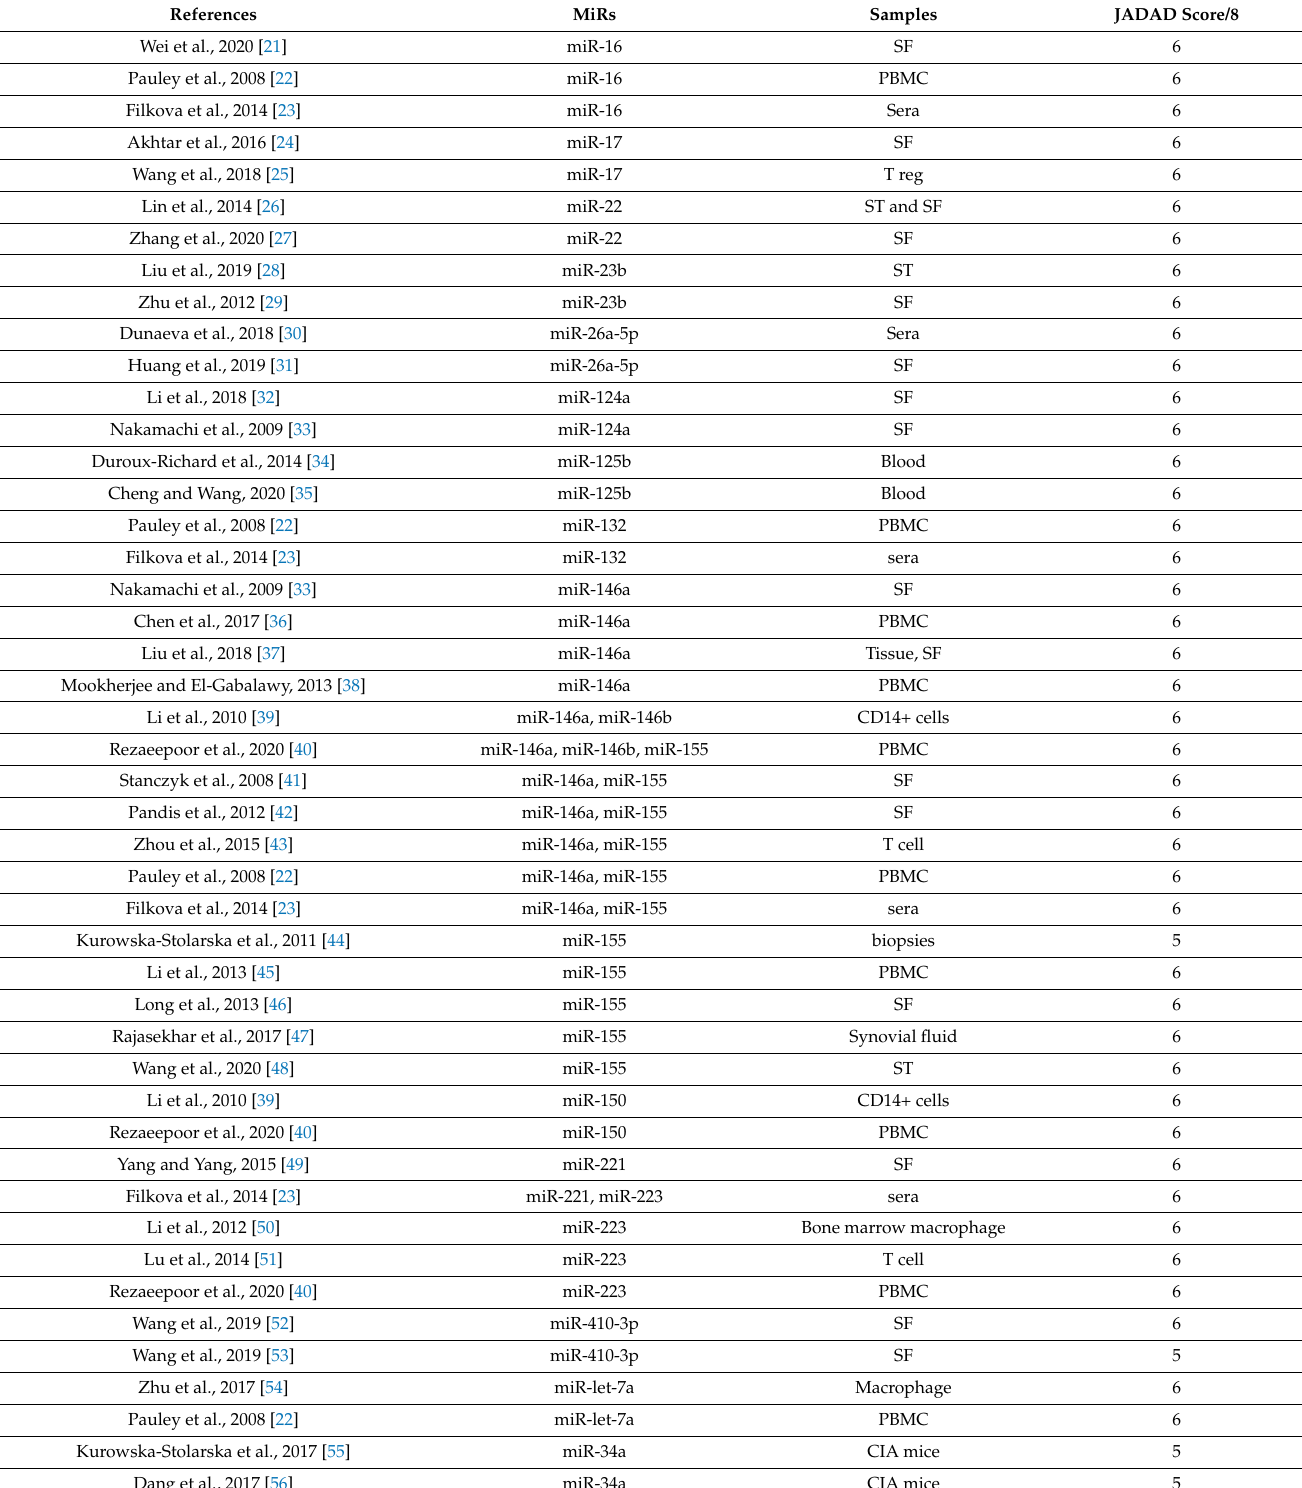
Table 1. Characteristics of the studies included in mi-RNAs meta-analysis. PBMC: peripheral blood mononuclear cell, ST: synovial tissue, CIA: collagen-induced